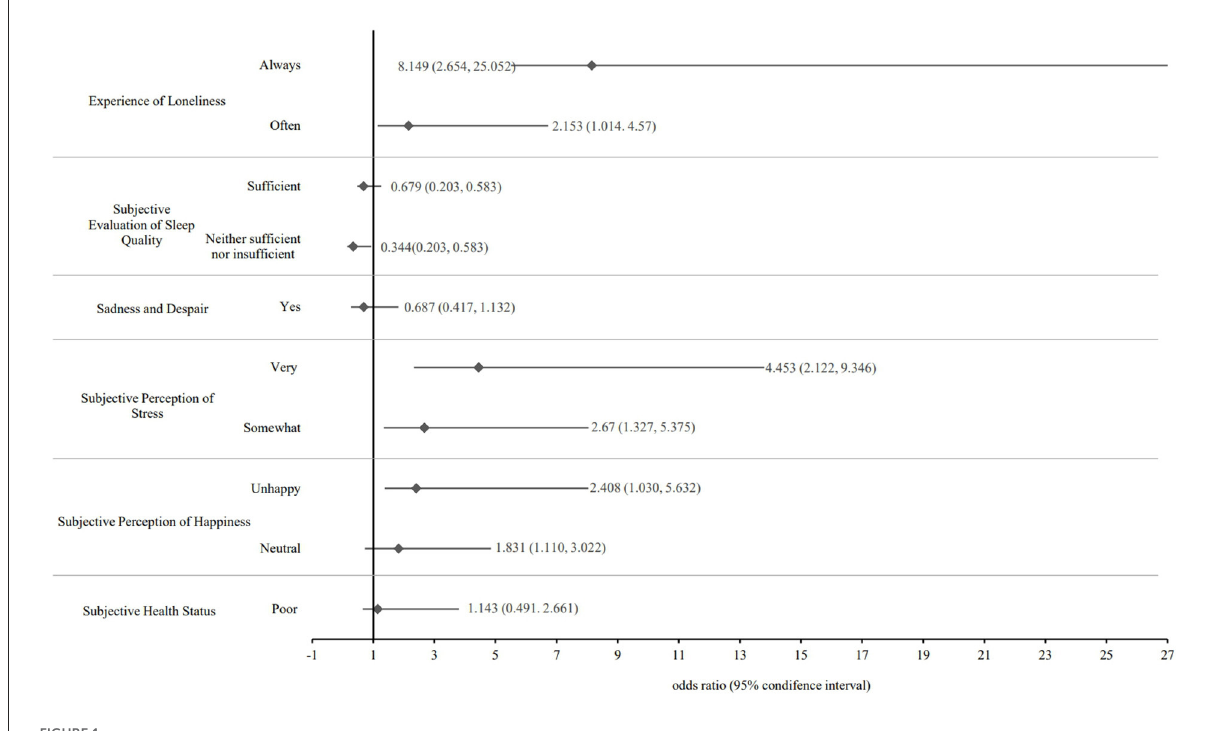
FIGURE1 Forest plot of the odds ratios for mental health